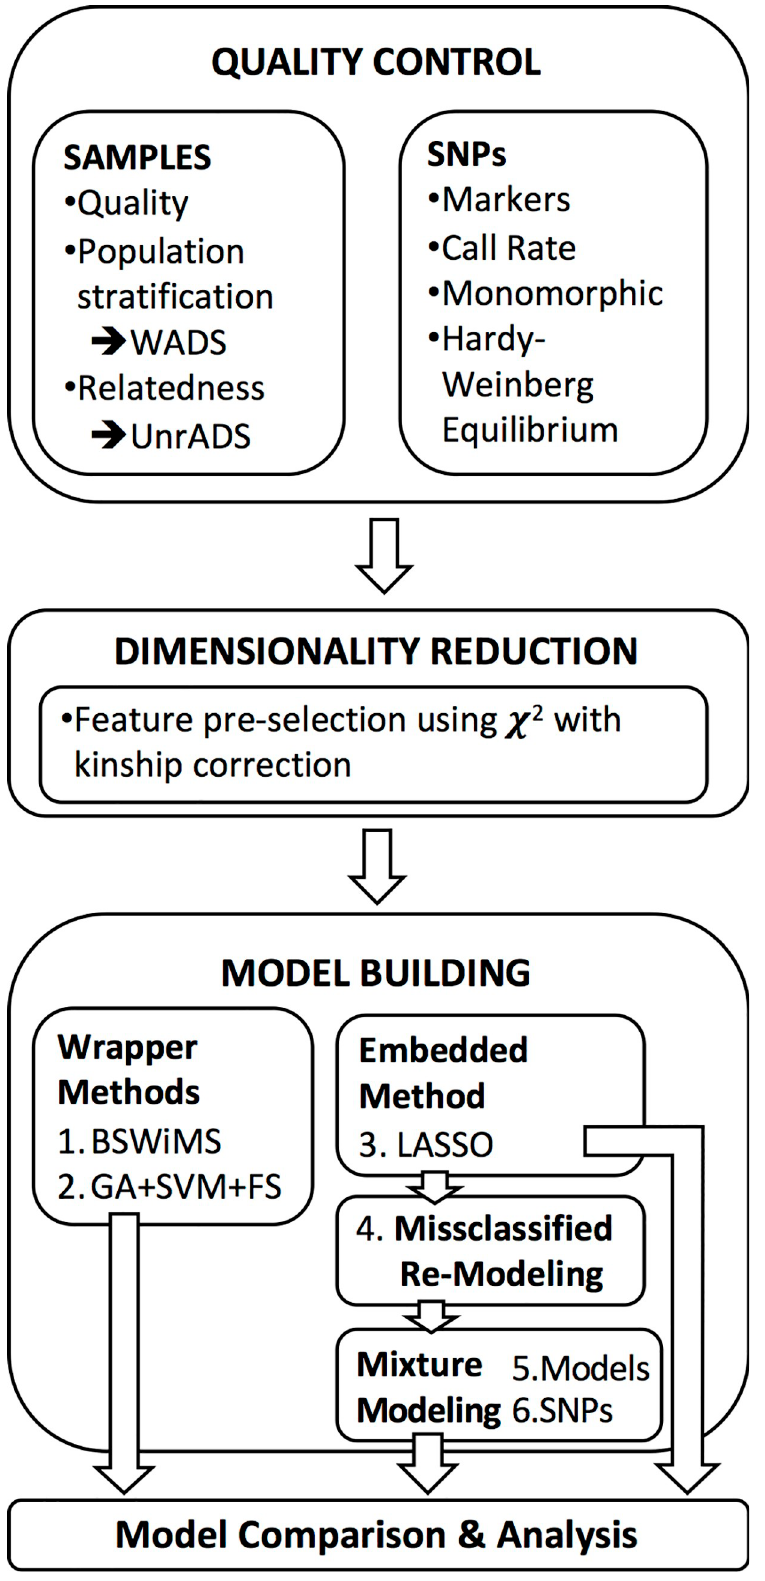
Fig 1. Schematic representation of the analysis. https://doi.org/10.1371/journal.pone.0232103.g001 PLOS ONE | https://doi.org/10.1371/journal.pone.0232103 April 23,